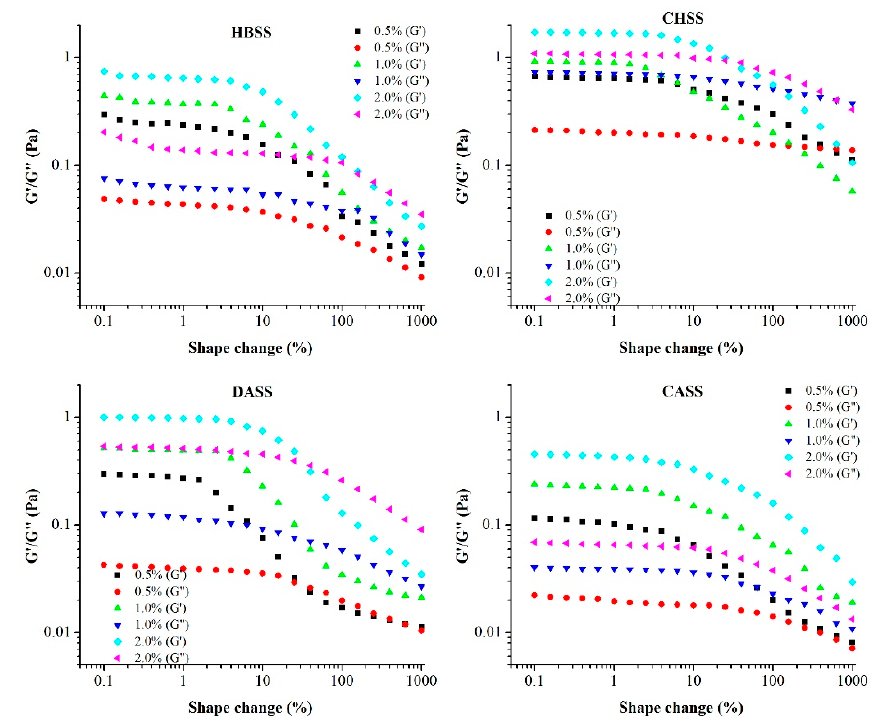
Figure 7. Variation of apparent viscosity of 1% MLPs with addition of different concentrations of CaCl2 at 20 °C.